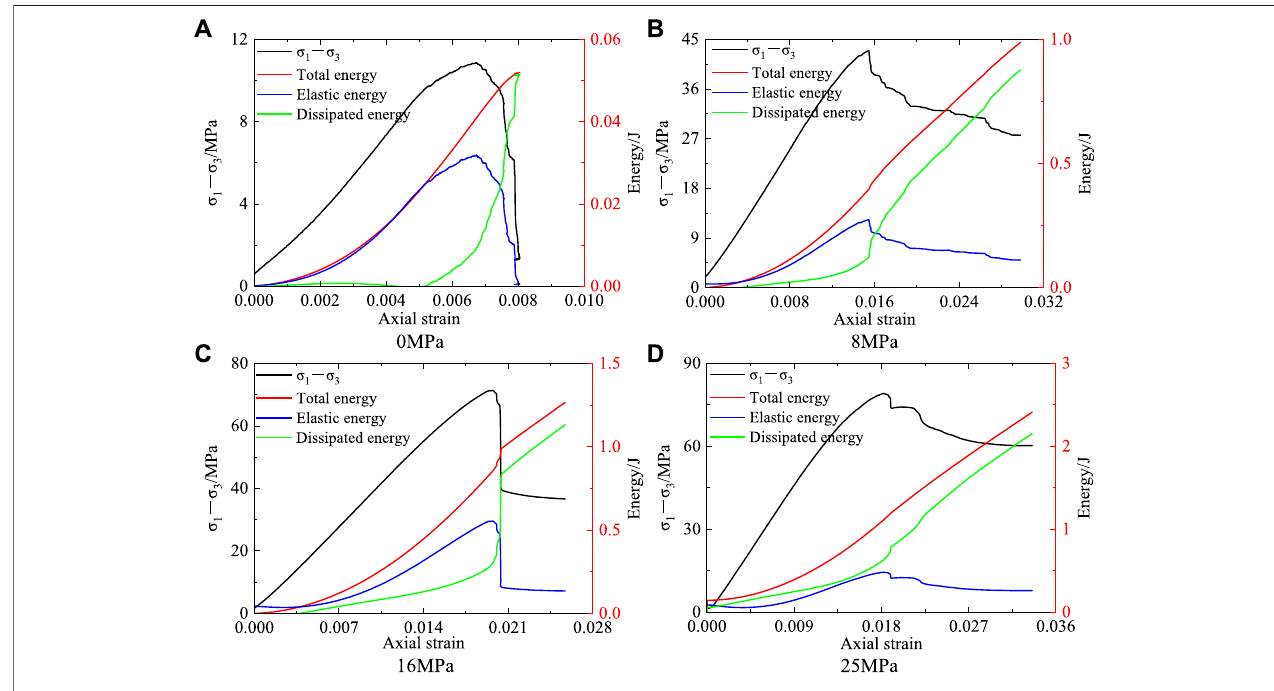
FIGURE 7 | Stress – strain curve and energy evolution process of coal and rock. (A) 0 MPa, (B) 8 MPa, (C) 16 MPa, (D) 25 MPa.